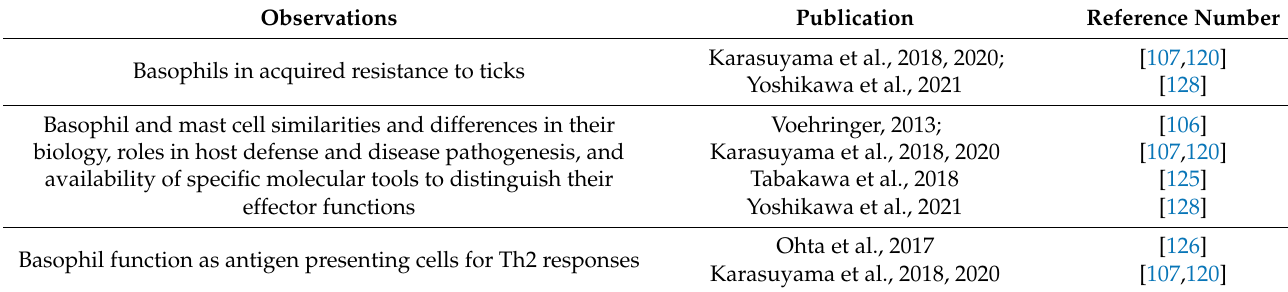
Table 3. Basophils as key cells in expression of acquired tick